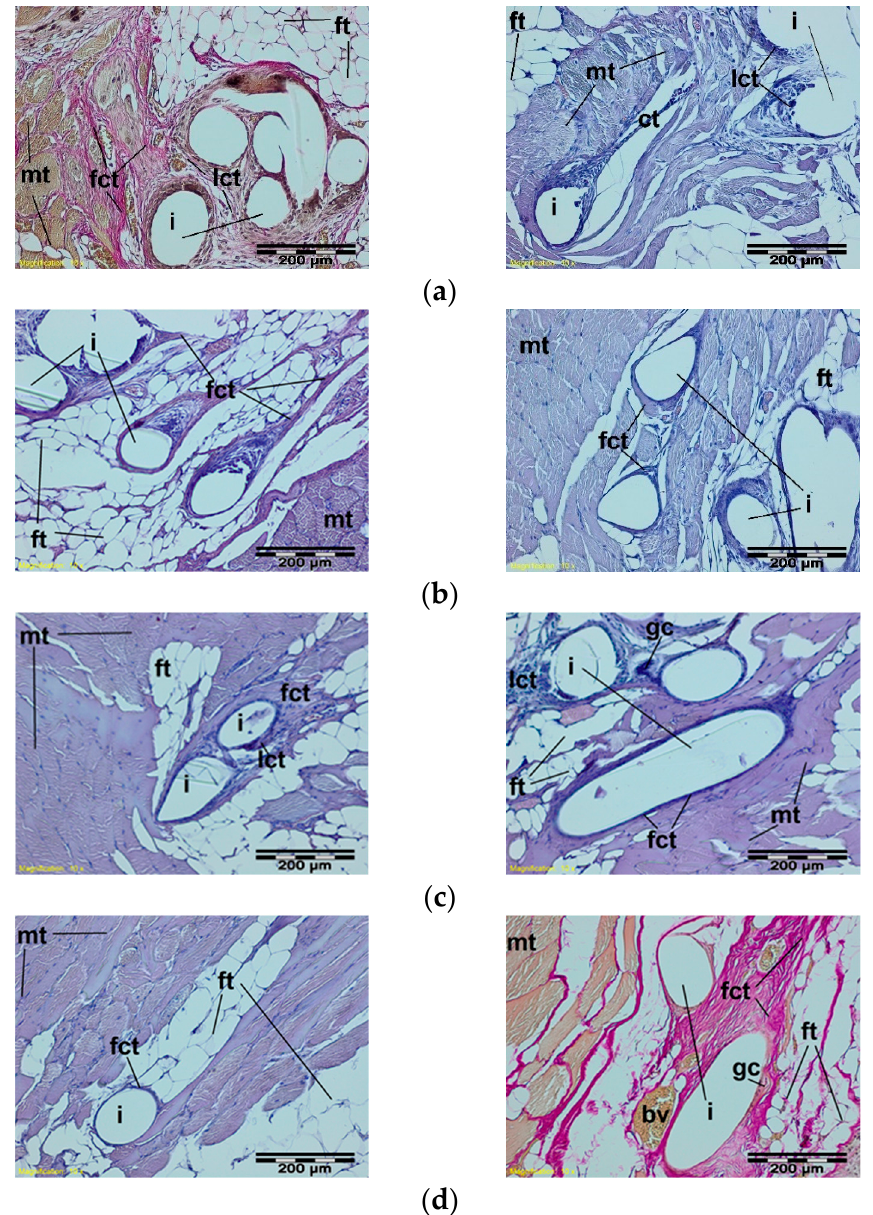
Figure 8. A microscopic view of the PACVD-modified sample (left side) and the reference (right side) after 9 ( a ), 12 ( b ), 26 ( c ), or 56 weeks ( d ) after the intramuscular implantation. In the muscle tissue (mt), the monofilaments of knitted implants (i) are surrounded by fibrous connective tissue (fct) with blood vessels (bv) and bands of fatty infiltrate (ft). Loose connective tissue (lct) with single polynuclear macrophages (gc) in the immediate vicinity of the implant structures (i) is visible. Magnification 100×, Stain. HE and VG.